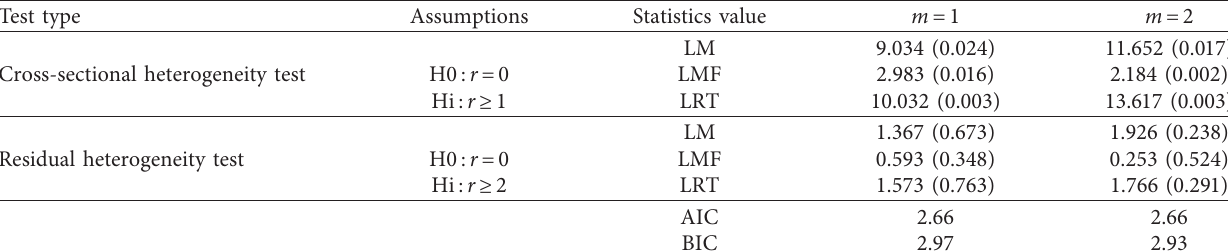
Table 3: Cross-sectional heterogeneity test and residual heterogeneity test of the panel smoothing threshold regression model. Test